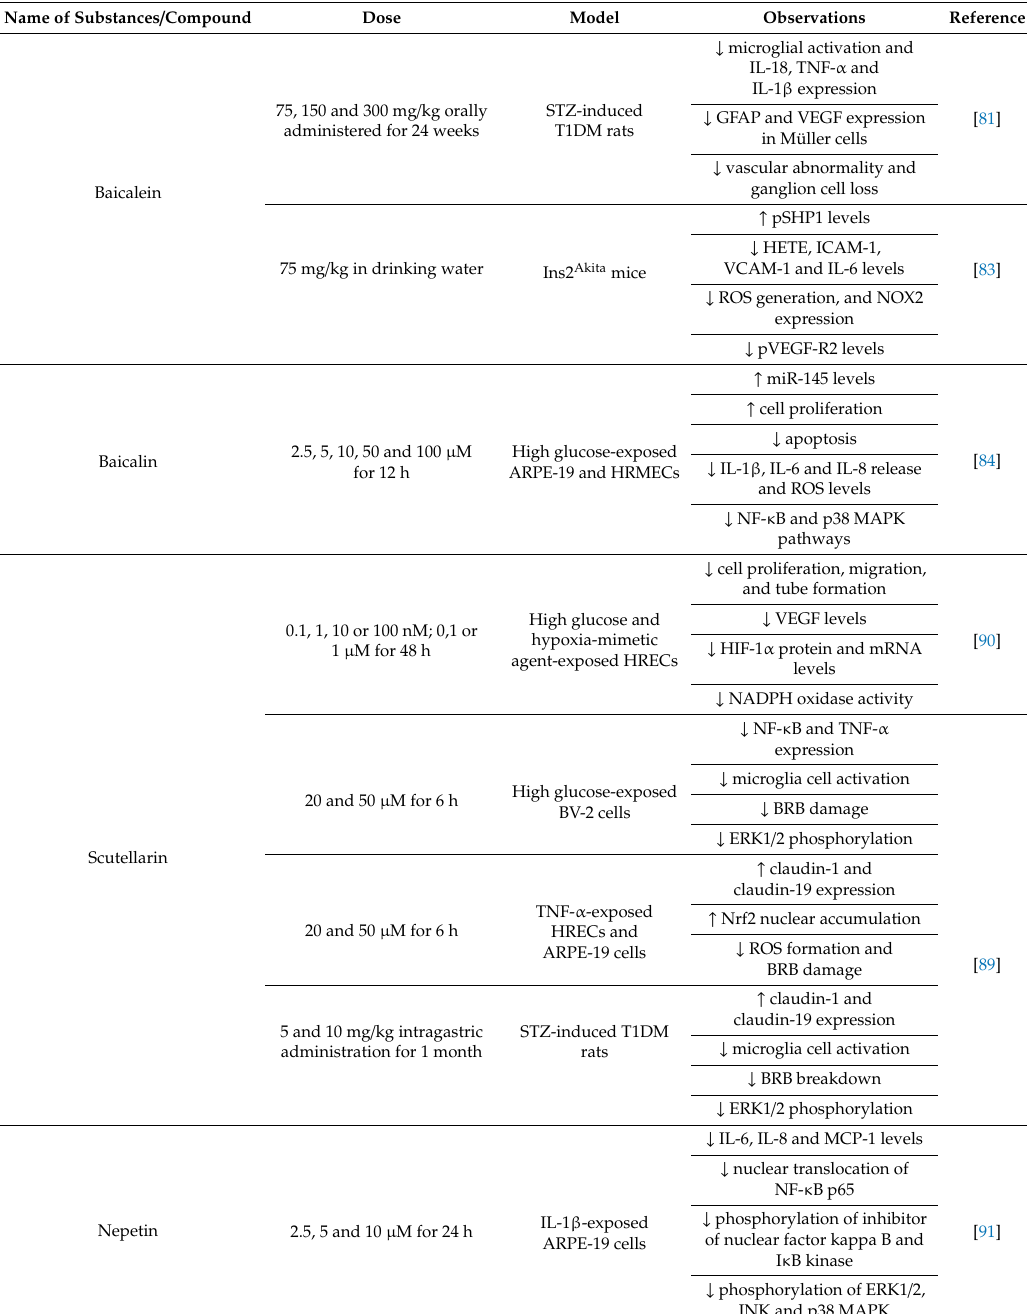
Table 4. E ff ects of flavones on cellular and molecular mechanisms a ff ected by diabetic retinopathy. Name of Substances /